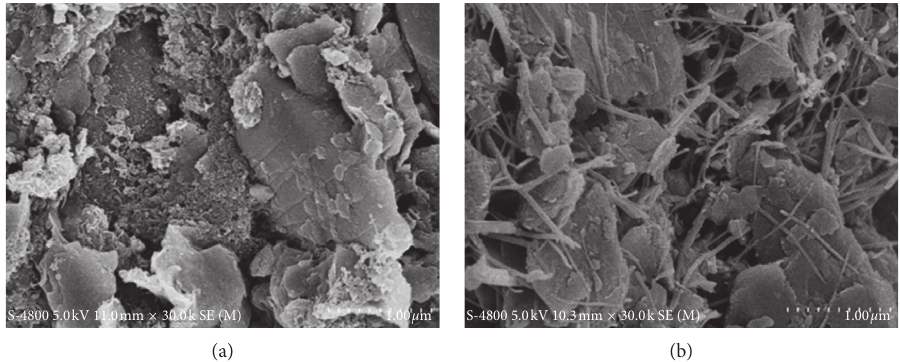
Figure 6: Micrographs (SEM) at 30000 magnification of (a) raw sludge and (b) S/S